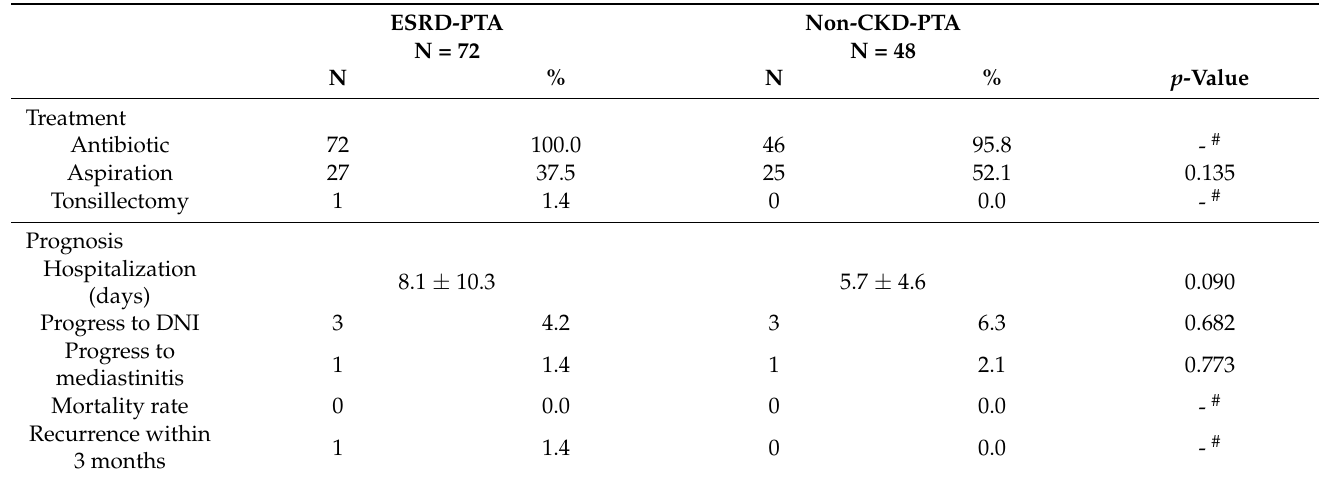
Table 4. The treatment modalities and prognosis of PTA in ESRD and non-CKD